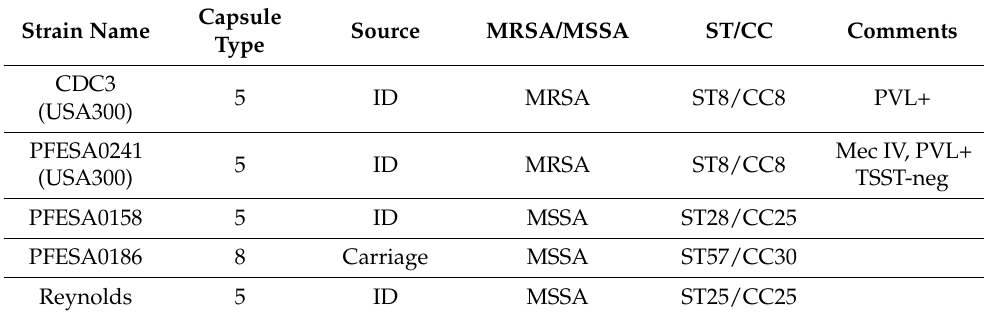
Table 1. S. aureus Strains Used in These